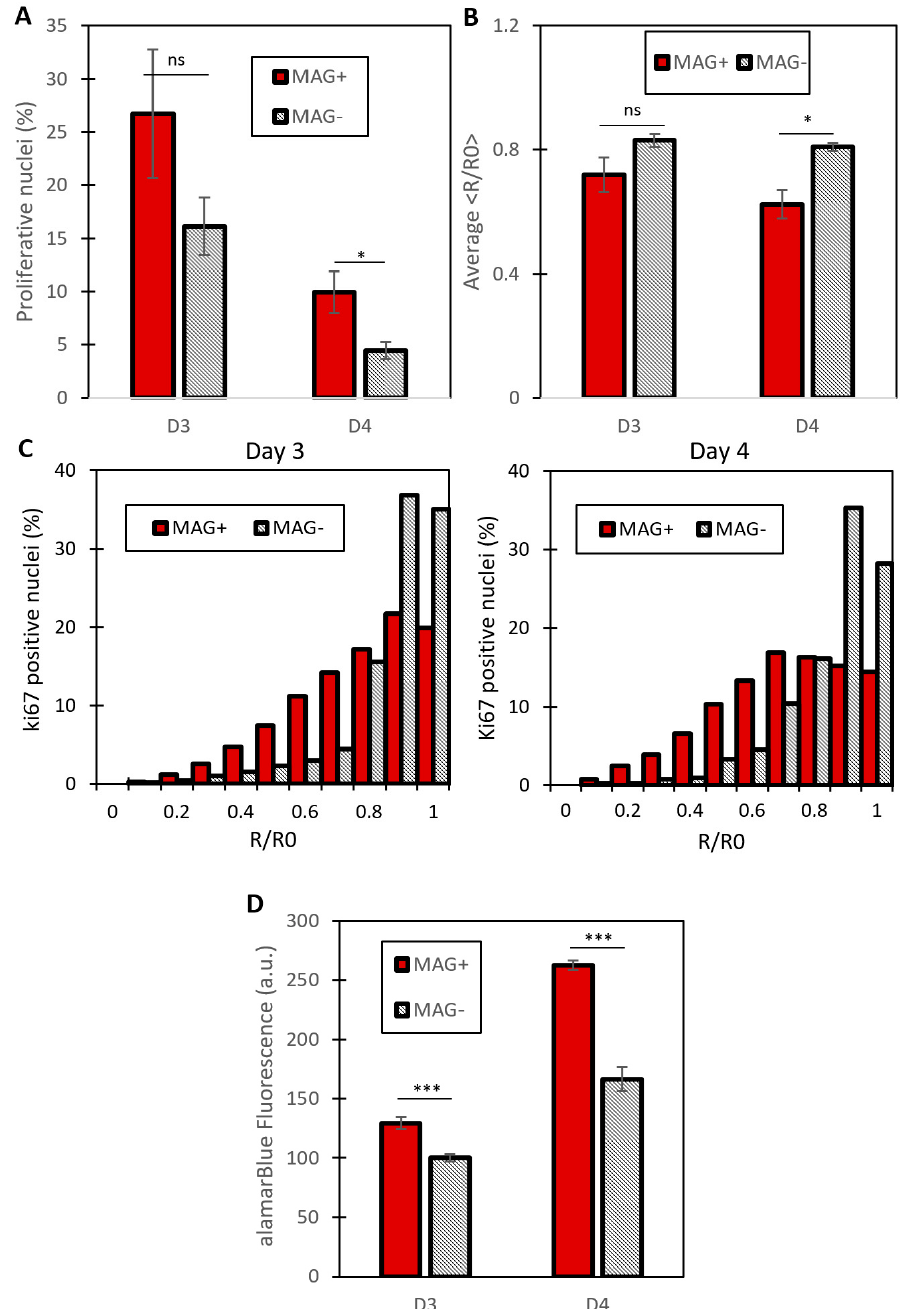
Figure 3. Quantification of cell proliferation of compressed (MAG+) or free (MAG − ) spheroids. ( A ) Percentage of proliferating cells for MAG+ and MAG − spheroids (respectively red and grey bars) at day 3 and day 4 of spheroid maturation. MAG+ spheroids experience an increase in the number of proliferating cells for the two days. Proliferation is evaluated as the ratio between the number of Ki67-positive nuclei and the total number of nuclei (at day 3, n = 3 for both conditions, at day 4, n = 3 for MAG − , n = 5 for MAG +, * p < 0.05). ( B ) Average of the normalized distance <R/R0> for the two conditions at the two maturation times (days 3 and 4). This distance represents the localization from the spheroid center of a Ki67 positive nucleus. This decreases for the MAG+ spheroids, demonstrating an increase in the proliferative nuclei toward the MAG+ spheroid center ( n = 3 spheroids for both conditions at day 3; n = 3 and n = 5 spheroids at day 4 for MAG+ and MAG − conditions, respectively; p < 0.05). ( C ) Cumulative distributions of the normalized distance <R/R0>.